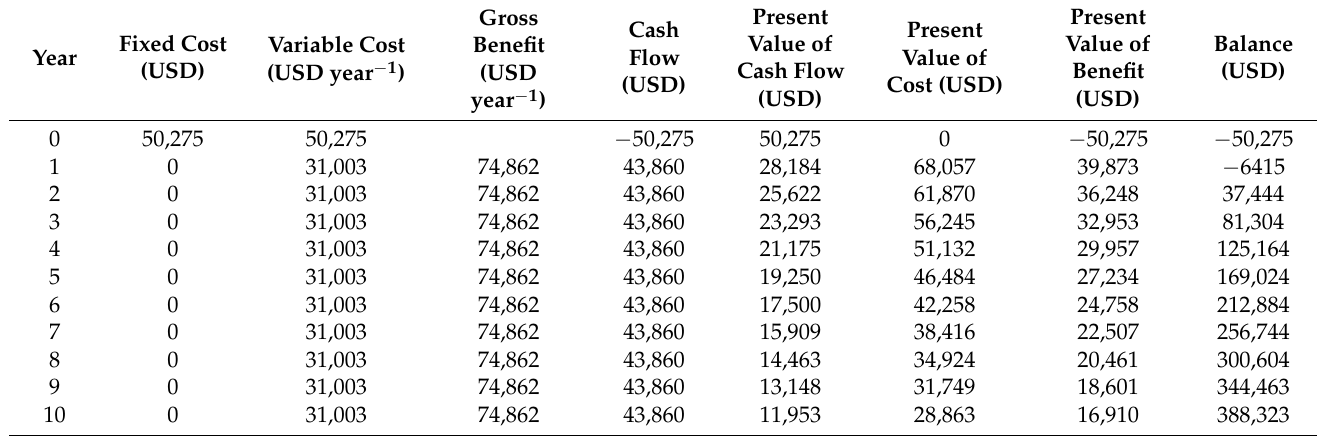
Table 7. NPV, BCR, IRR, and PP calculation for medium combine at DF 10%.